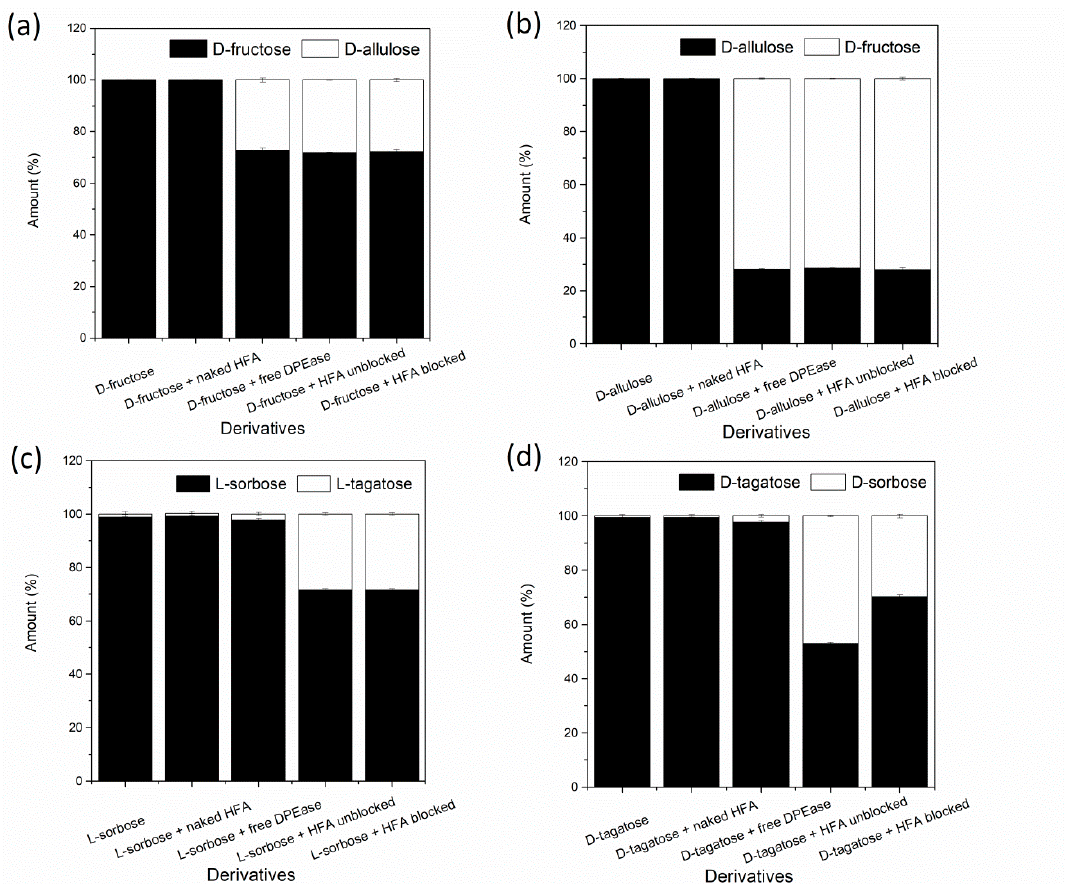
Figure 8. Substrate specificity of free and immobilised DPEase. ( a ) D-fructose/D-fructose + naked HFA/ D-fructose + free DPEase/D-fructose + HFA unblocked/D-fructose + HFA blocked DPEase; ( b ) D-allulose/D-allulose + naked HFA/D-allulose + free DPEase/D-allulose + HFA unblocked/D-allulose + HFA blocked; ( c ) L-sorbose/L-sorbose + naked HFA/L-sorbose + free DPEase/L-sorbose + HFA unblocked/L-sorbose + HFA blocked; ( d ) D-tagatose/D-tagatose + naked HFA/D-tagatose + free DPEase/D-tagatose + HFA unblocked/D-tagatose + HFA blocked.